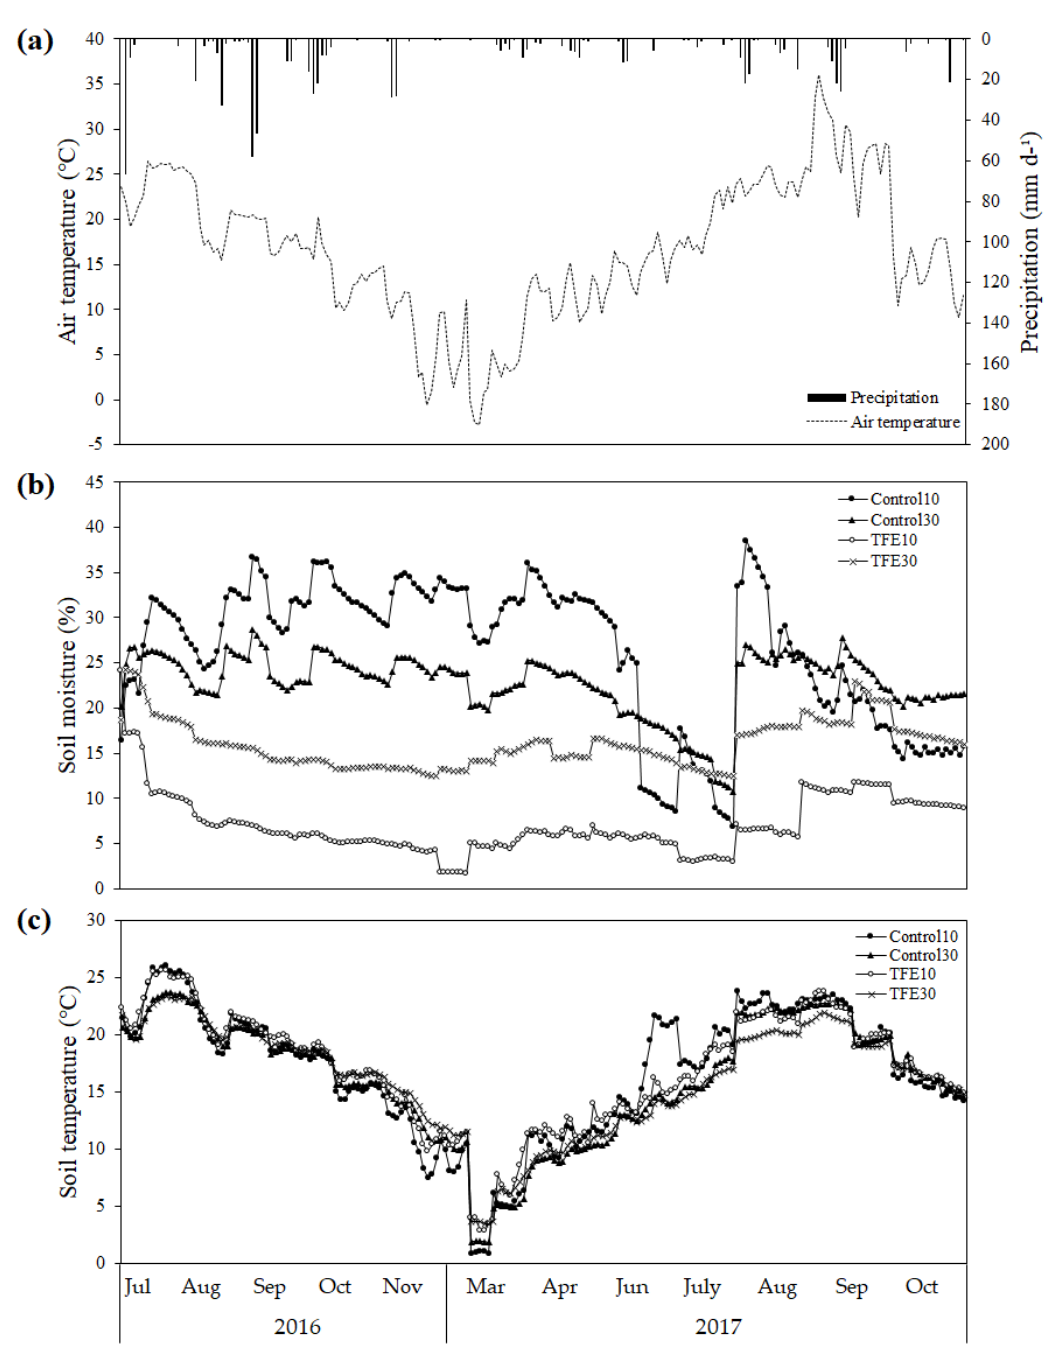
Figure 3. Seasonal variation of ( a ) daily mean air temperature and precipitation, ( b ) soil water content, ( c ) soil temperature in the control and TFE plots. Control10, TFE10 and Control30, TFE30 represent the mean value at 10 cm and 30 cm soil depth in the control plots and TFE plots, respectively. Each value is average of three replications for each plot.